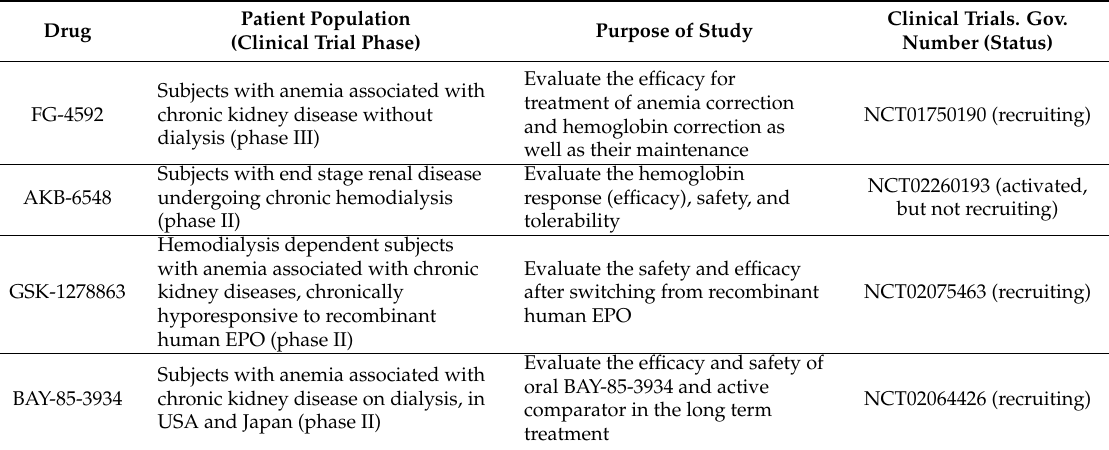
Table 4. Examples of current clinical trials targeting